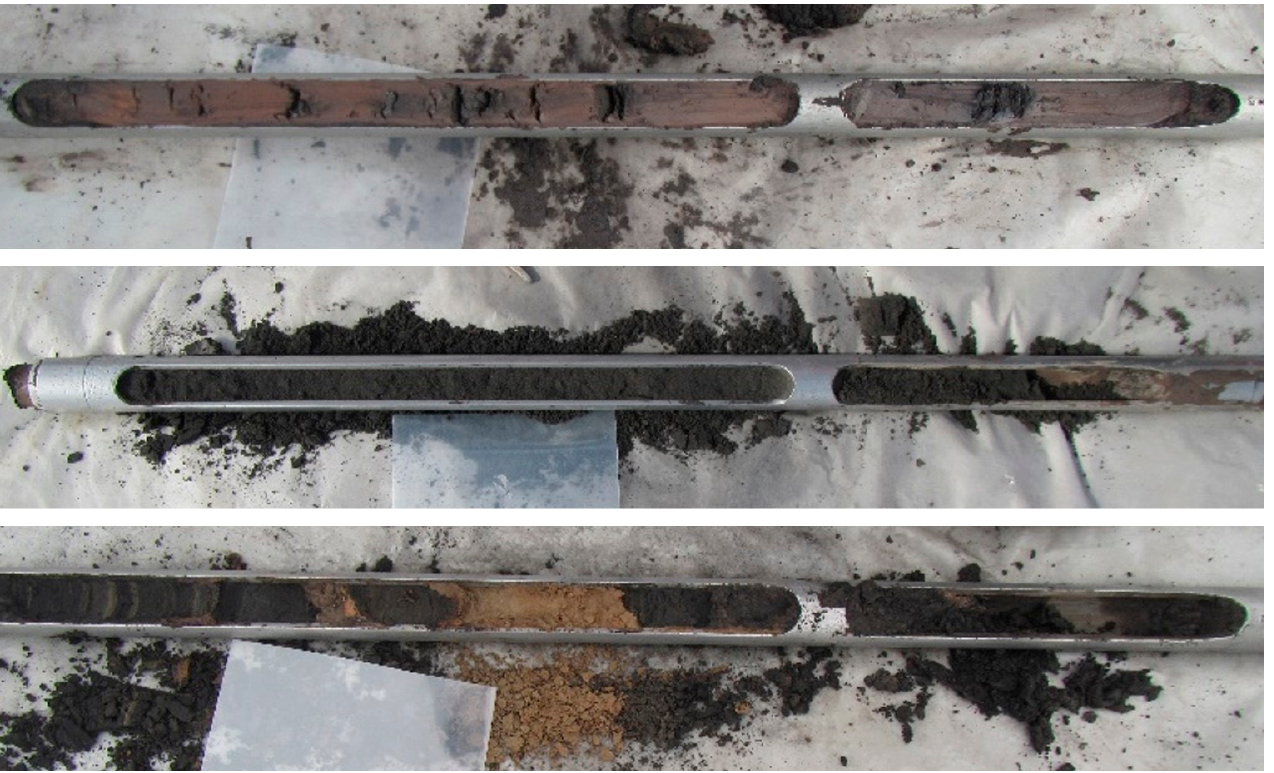
Figure 2. Probe with sample material from the Taltal tailings. Top : reddish copper rich clay. Center : dark magnetite rich sandy material. Bottom : yellowish layer probably from episodic gold processing (direct information of the owner of the tailings). Length of probe 1 m.